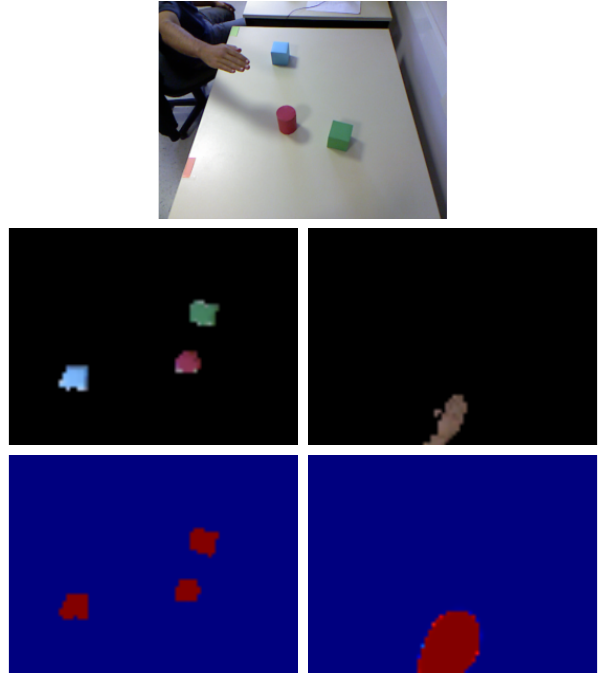
Figure 4: Detection of hand and objects. The top row shows the camera image. The middle row shows the segmented objects (left) as well as the hand (right). The bottom row shows the activation of the object (left) and hand (right) detection